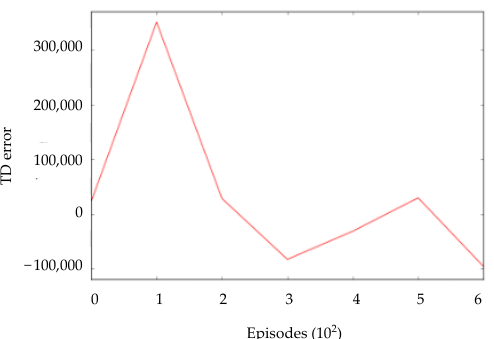
Figure 13. Average cumulative TD error of a DQN agent in the Gazebo simulator.